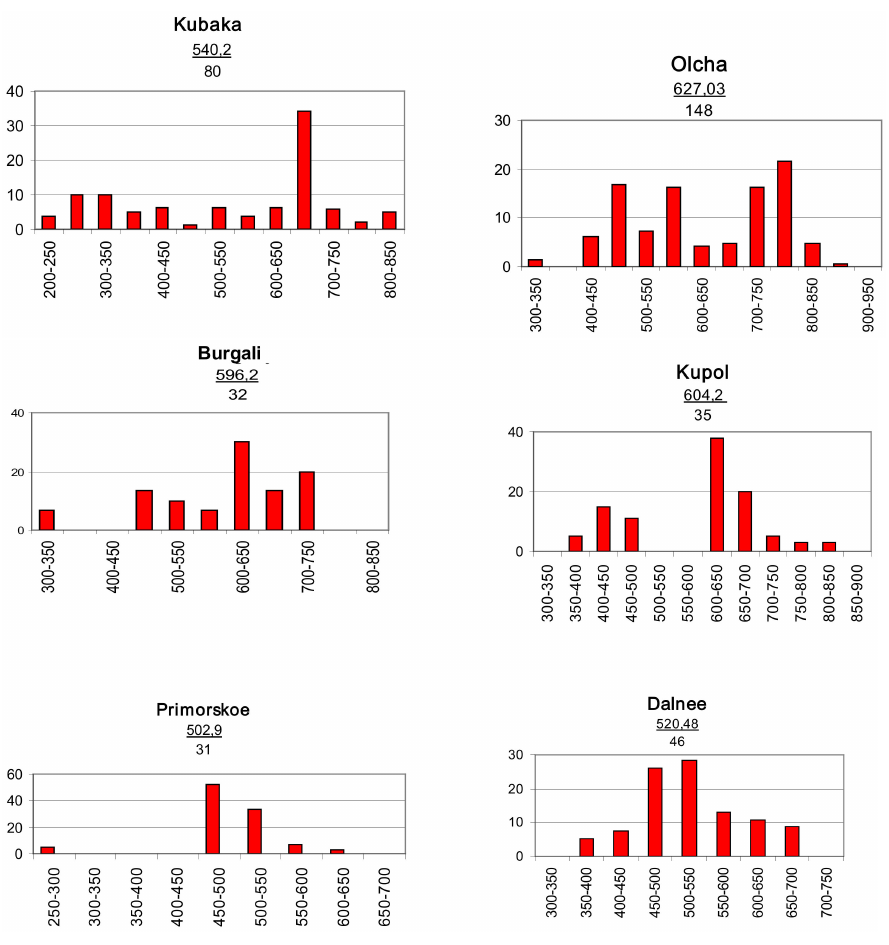
Figure 8. Fineness histograms of native gold for deposits of gold–silver adularia GIT: along the abscissa axis—frequency of occurrence, %; along the x -axis, fineness intervals, ‰; in the numerator is the fineness, ‰, in the denominator is the number of determinations.